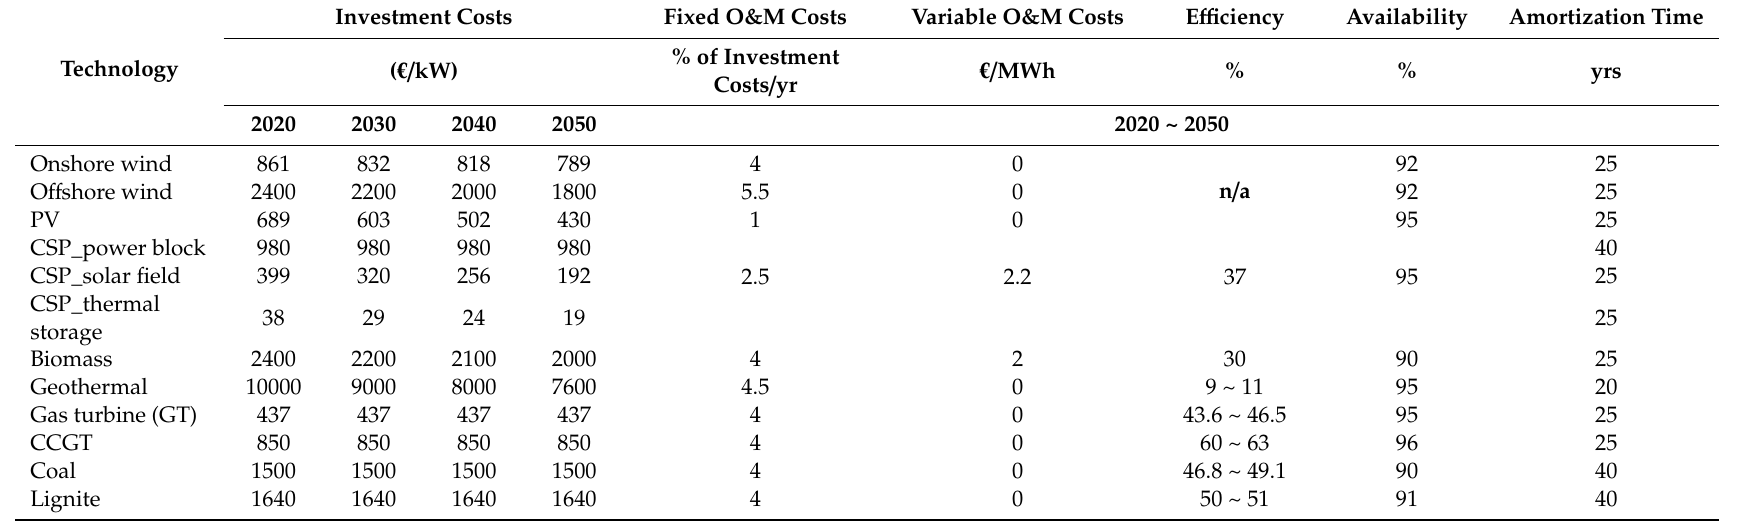
Table 1. Assumed economic and technological parameters for power generation based on